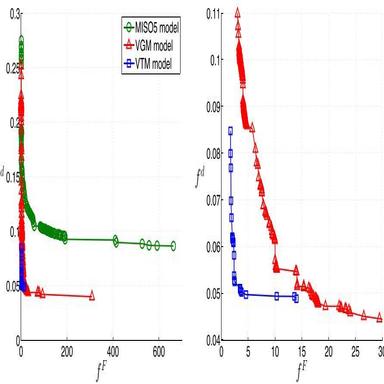
Pareto fronts for the MISO5, VGM and VTM models.